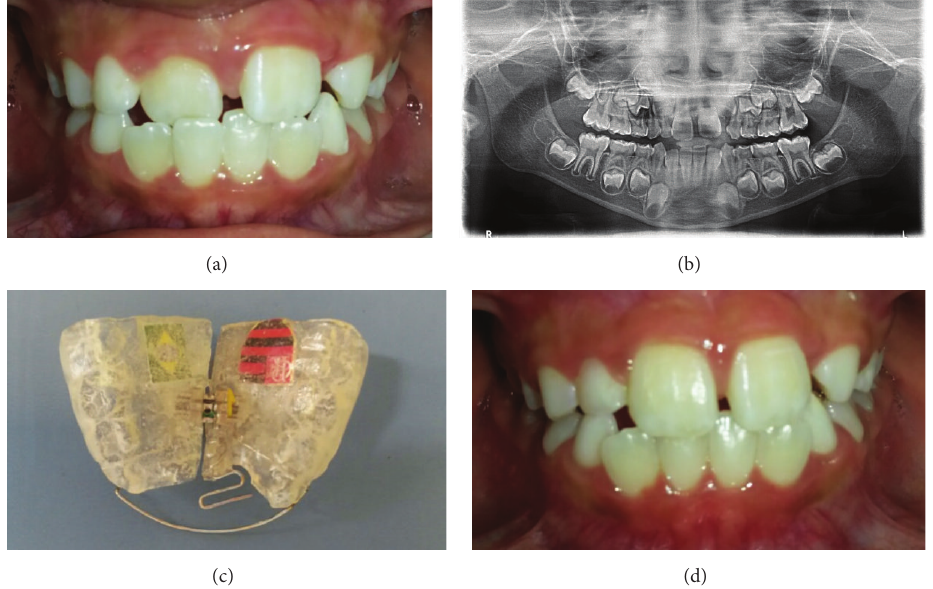
Figure 1: Case 1. (a) Anterior dental crossbite in the upper right central incisor. (b) Panoramic radiograph showing no abnormality. (c) Removable orthodontic appliance with a protrusion spring for incisor in anterior crossbite. (d) Anterior crossbite correction after 3 months.